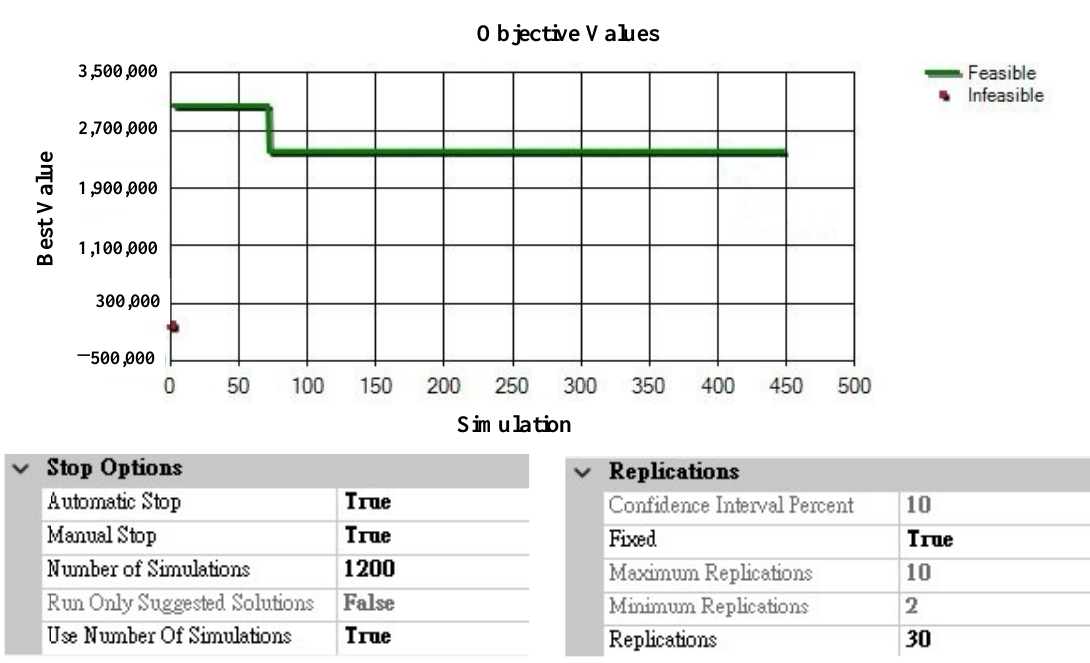
Figure 9. Settings for the numbers of iterations and replications.